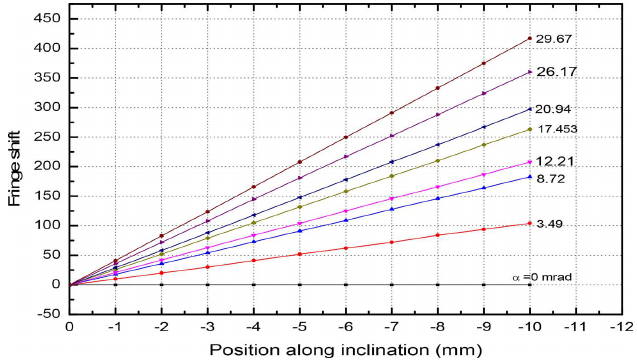
Figure 17 Fringe shift with different angle